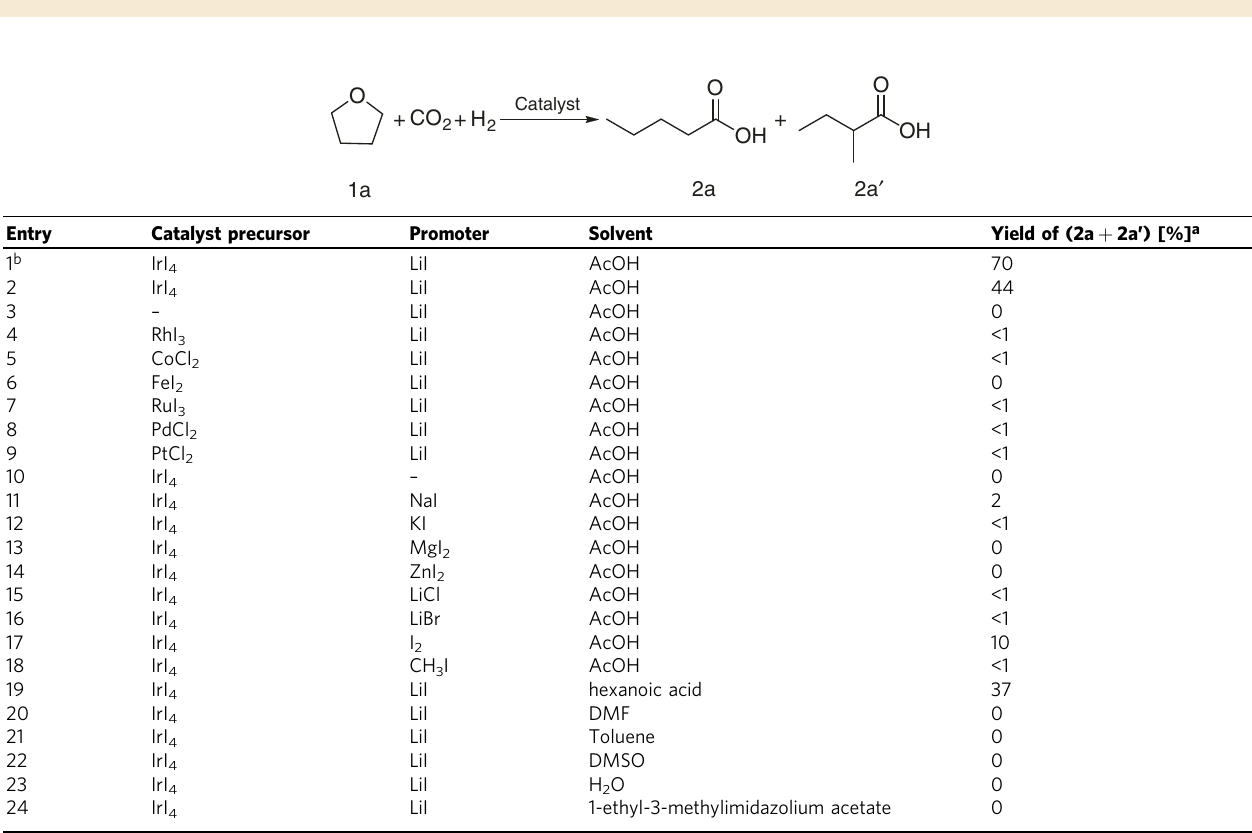
Table 1 Different catalytic systems for synthesizing C 5 carboxylic acids from THF, CO 2 , and H 2 .